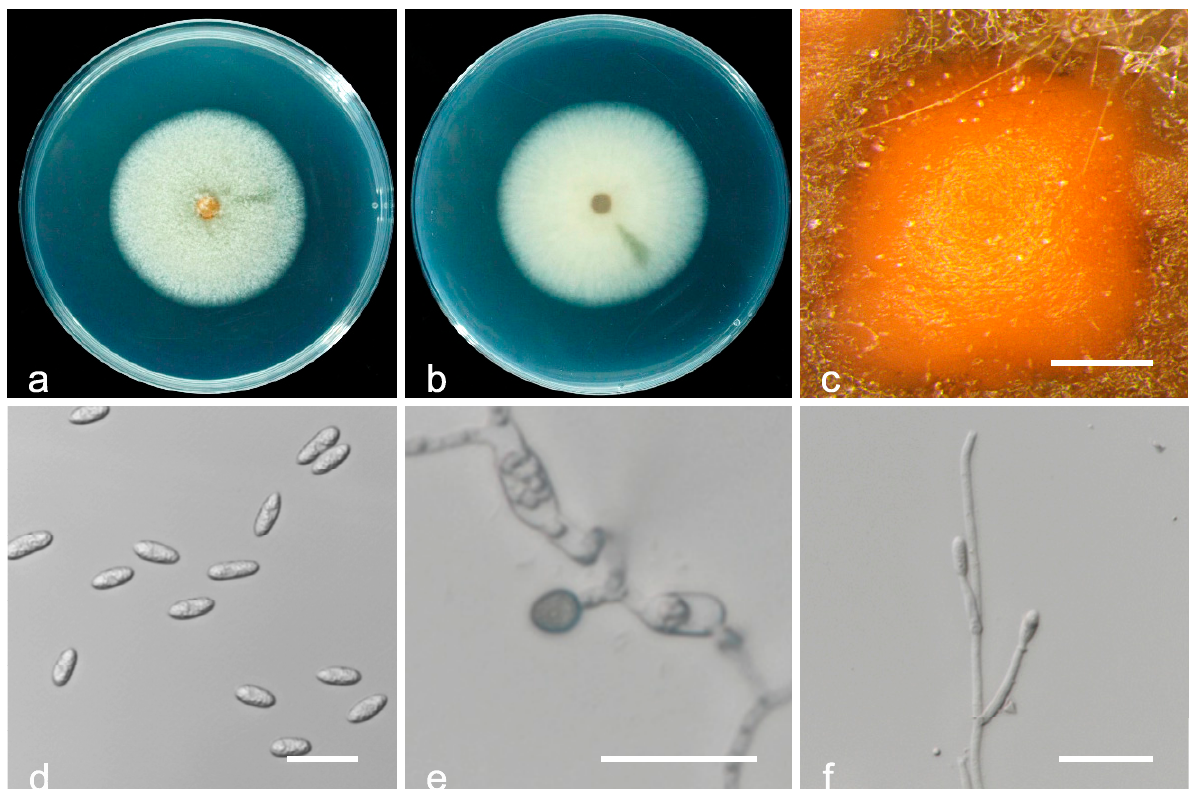
Figure 8. Biological characteristics of Colletotrichum nymphaeae . ( a , b ) Front and back view of six-day-old PDA culture; ( c ) conidiomata; ( d ) conidia; ( e ) appressoria; ( f ) conidiophores (( a – e ) isolate HBYC 1; ( f ) isolate SCCD 1). Scale bars: ( c ) = 200 µ m; ( d – f ) = 20 µ m. Description and illustration—Damm et al. NJC83, April 2017, Q. Tan, living culture HBYC1; Sichuan province, Chengdu city, on